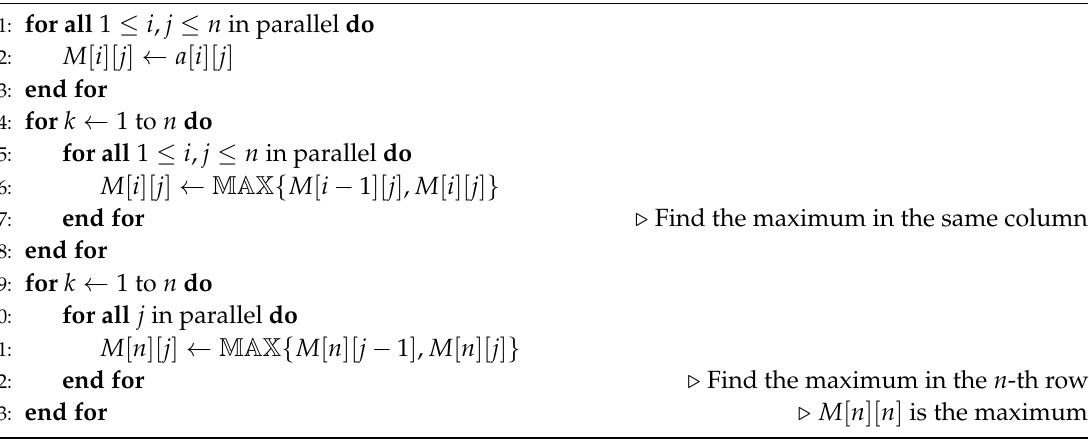
Algorithm 10 Find the maximum of a [ 1.. n ][ 1.. n ] in 2 n